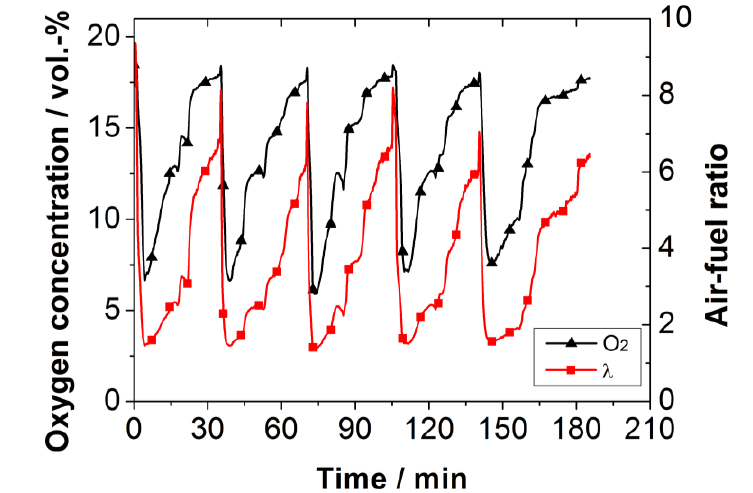
Figure 2. Oxygen concentration and ratio of actual air-fuel ratio to stoichiometric ratio (λ) in the exhaust gas during several burning cycles in the wood log